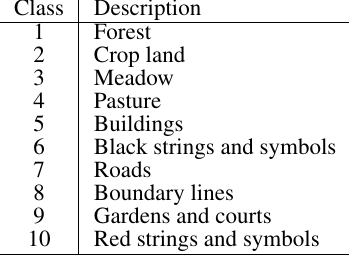
Table 1. LULC classes used for MLC